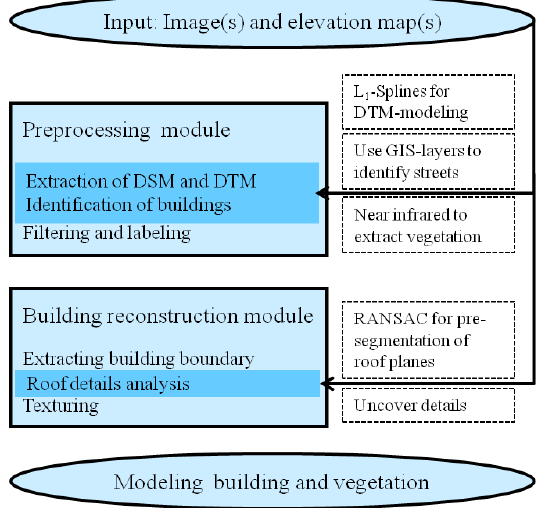
Figure 1: Essential steps of the algorithm. The most important innovations are specified by the dark-blue color and summarized in the boxes on the right.